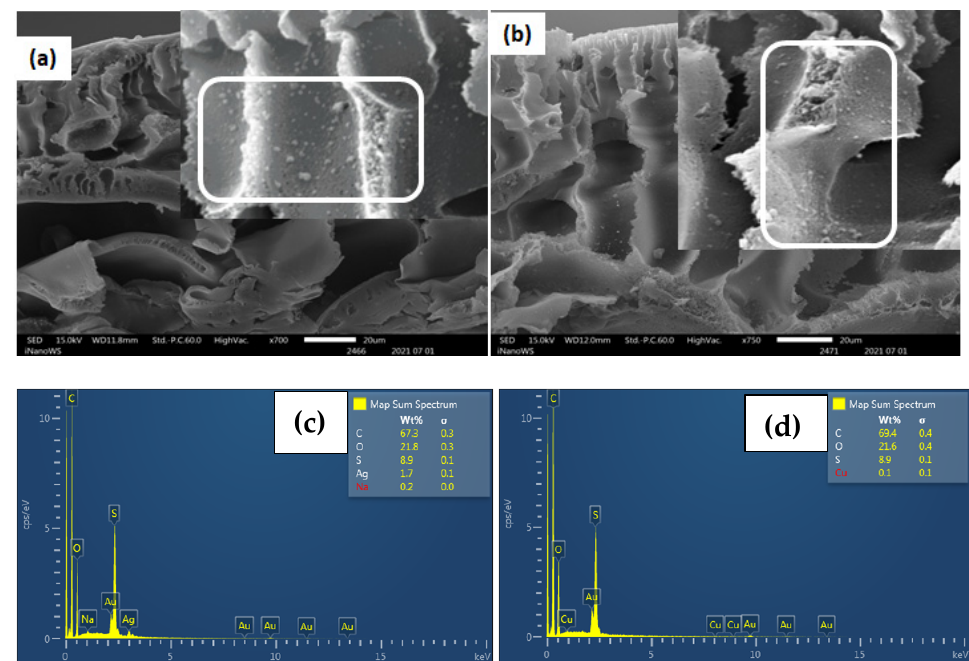
Figure 2. Cross-sectional images of functionalized Ag and Cu AEM-3.5 membranes: ( a ) AEM-Ag3 ( b ) AEM-Cu3. ( c ) EDS spectra of AEM-Ag3; ( d ) EDS spectra of AEM-Cu3.